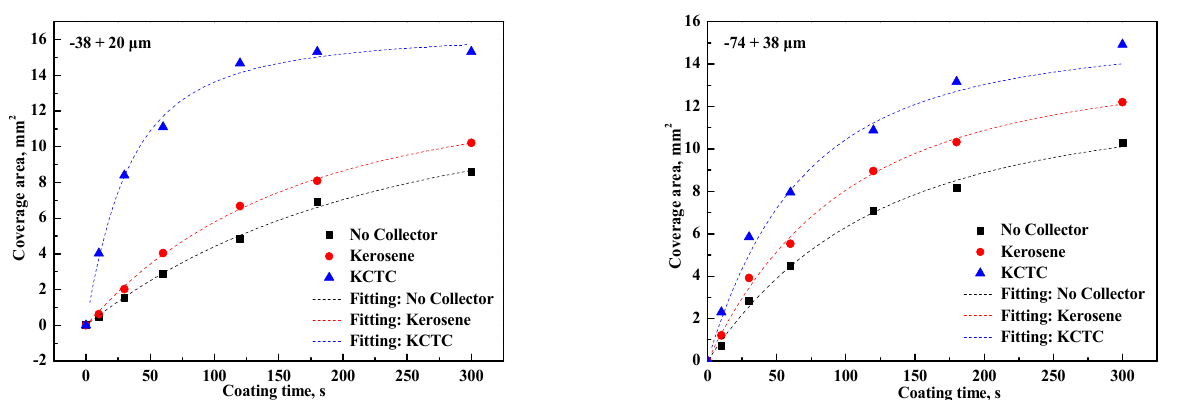
Figure 7. Attaching kinetics fitting of molybdenite particles to bubbles, using a classical first ‐ order model.